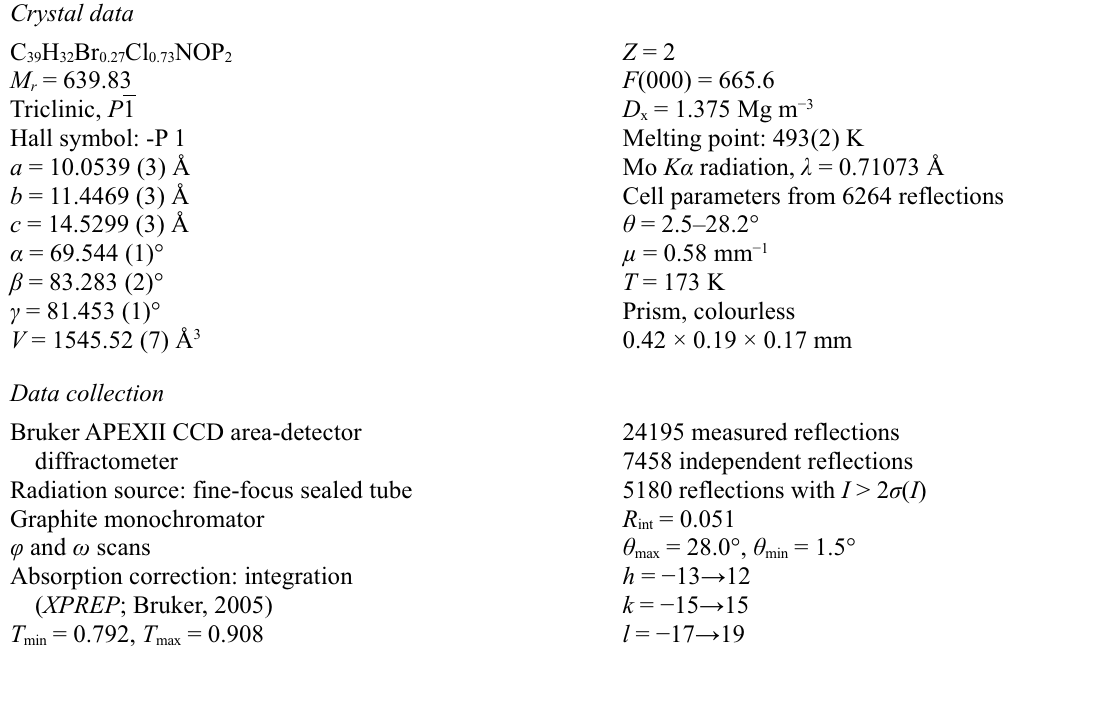
Figure 1 Molecular structure of (I) with thermal ellipsoids shown at 50% probability levels. 10-(3-bromo/chloropropyl)-4,6-bis(diphenylphosphino)-10 H -phenoxazine Crystal